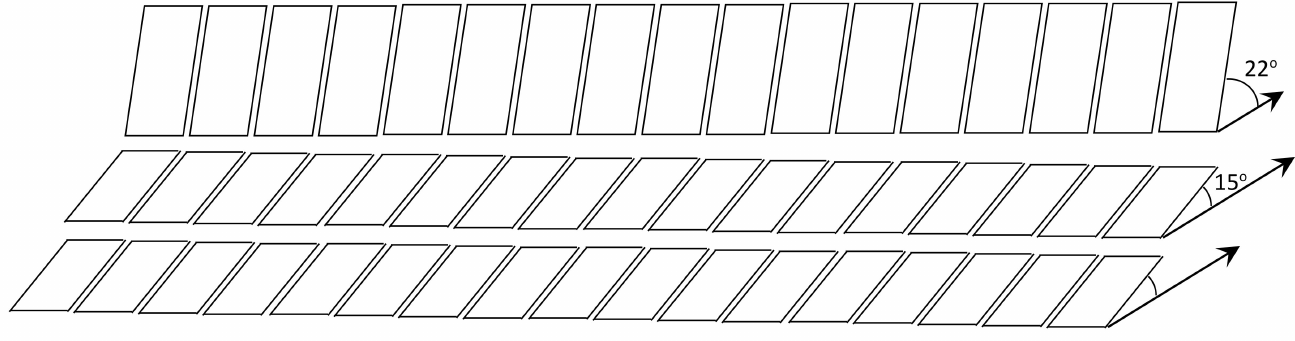
Figure 6. The configuration of the third